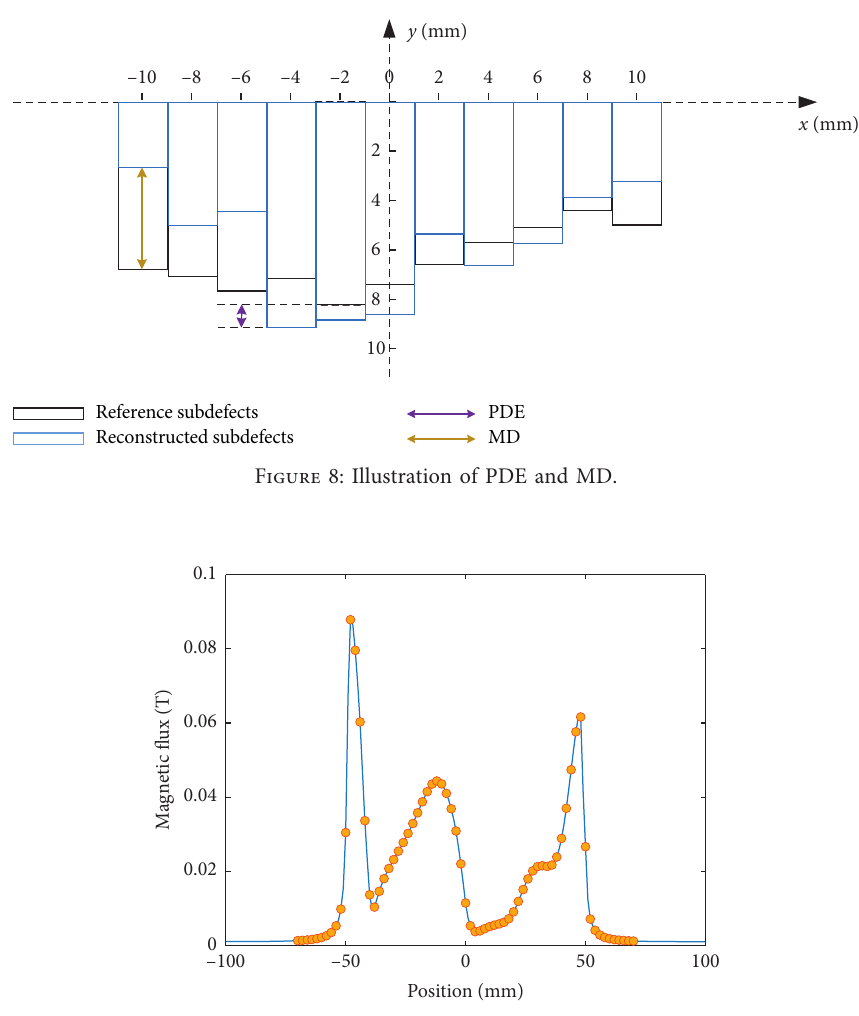
Figure 9: Illustration of sampling position of the inspection signal as part of